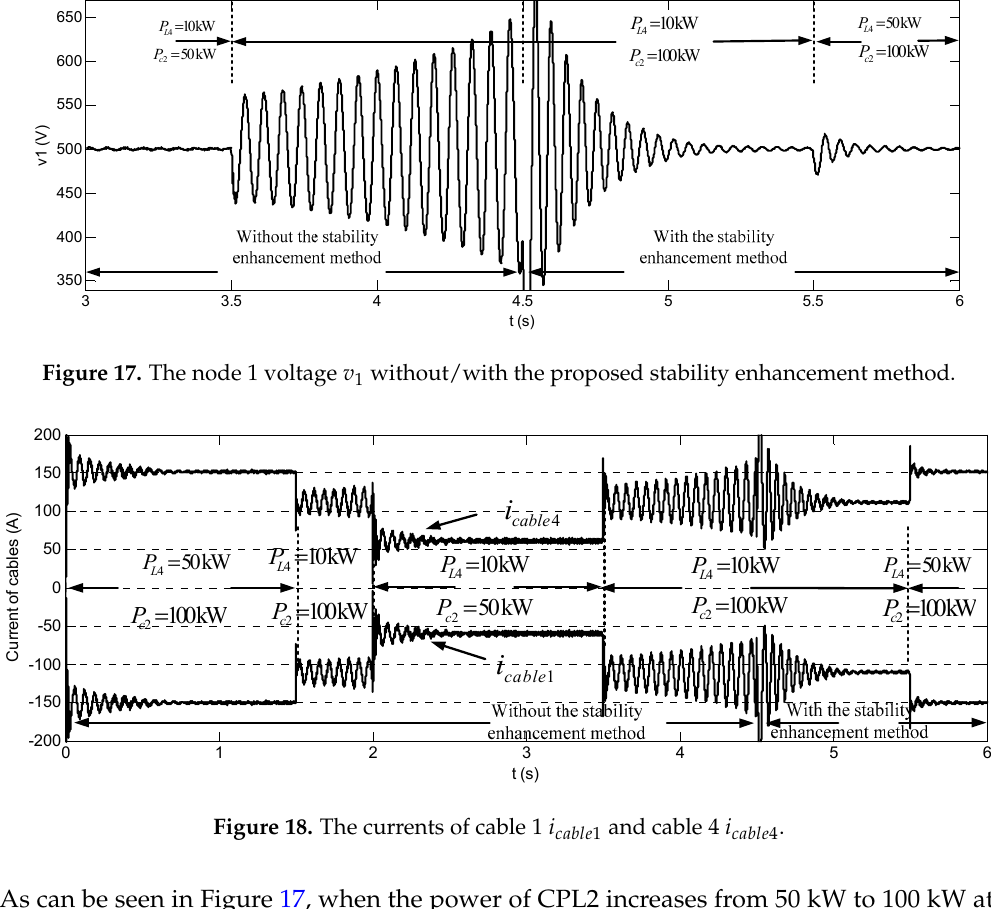
i and cable 4 1 cable